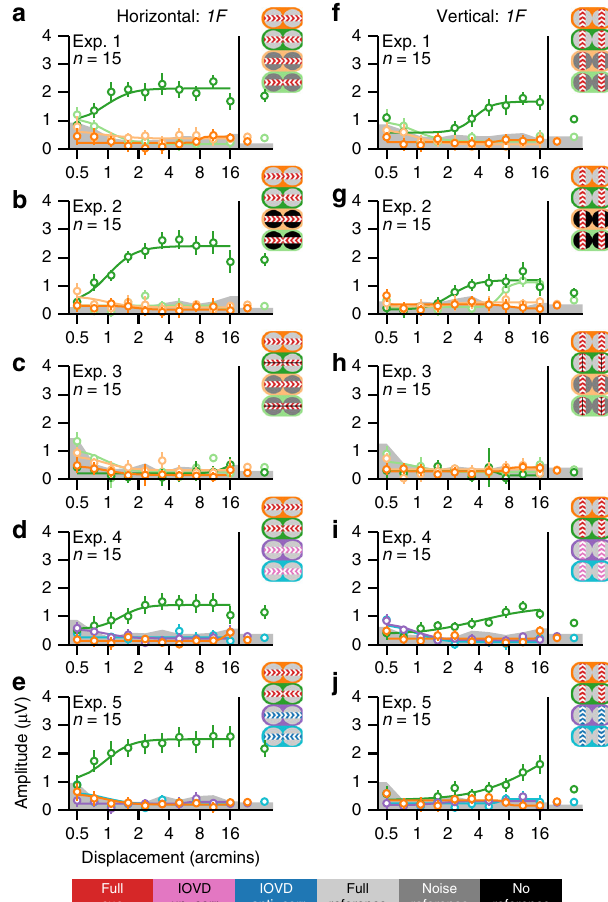
Fig. 6 Adult fi rst harmonic SSVEP response functions. a – e Displacement response functions for the horizontal direction of motion and f – j the vertical direction of motion. Averages across all displacements are shown on the right side of the response functions. Data are from the fi rst reliable component from an RC analysis derived from 1F data from all conditions, separately for each experiment. Scalp topographies for this component are shown in Supplementary Fig. 2. Each experiment had eight conditions, of which half were horizontal and the rest were vertical. The conditions are represented with icons, with the same color convention as in Fig. 2 and the color meanings shown in the legend in the bottom of the fi gure. Smooth curves are Naka – Rushton function fi ts to the data and gray bands at the bottom of the plots indicate the average background EEG noise level. Error bars plot ±1 standard error of the mean (SEM). As expected, Experiment 3 produced no reliable 1F response for any condition, see text for additional